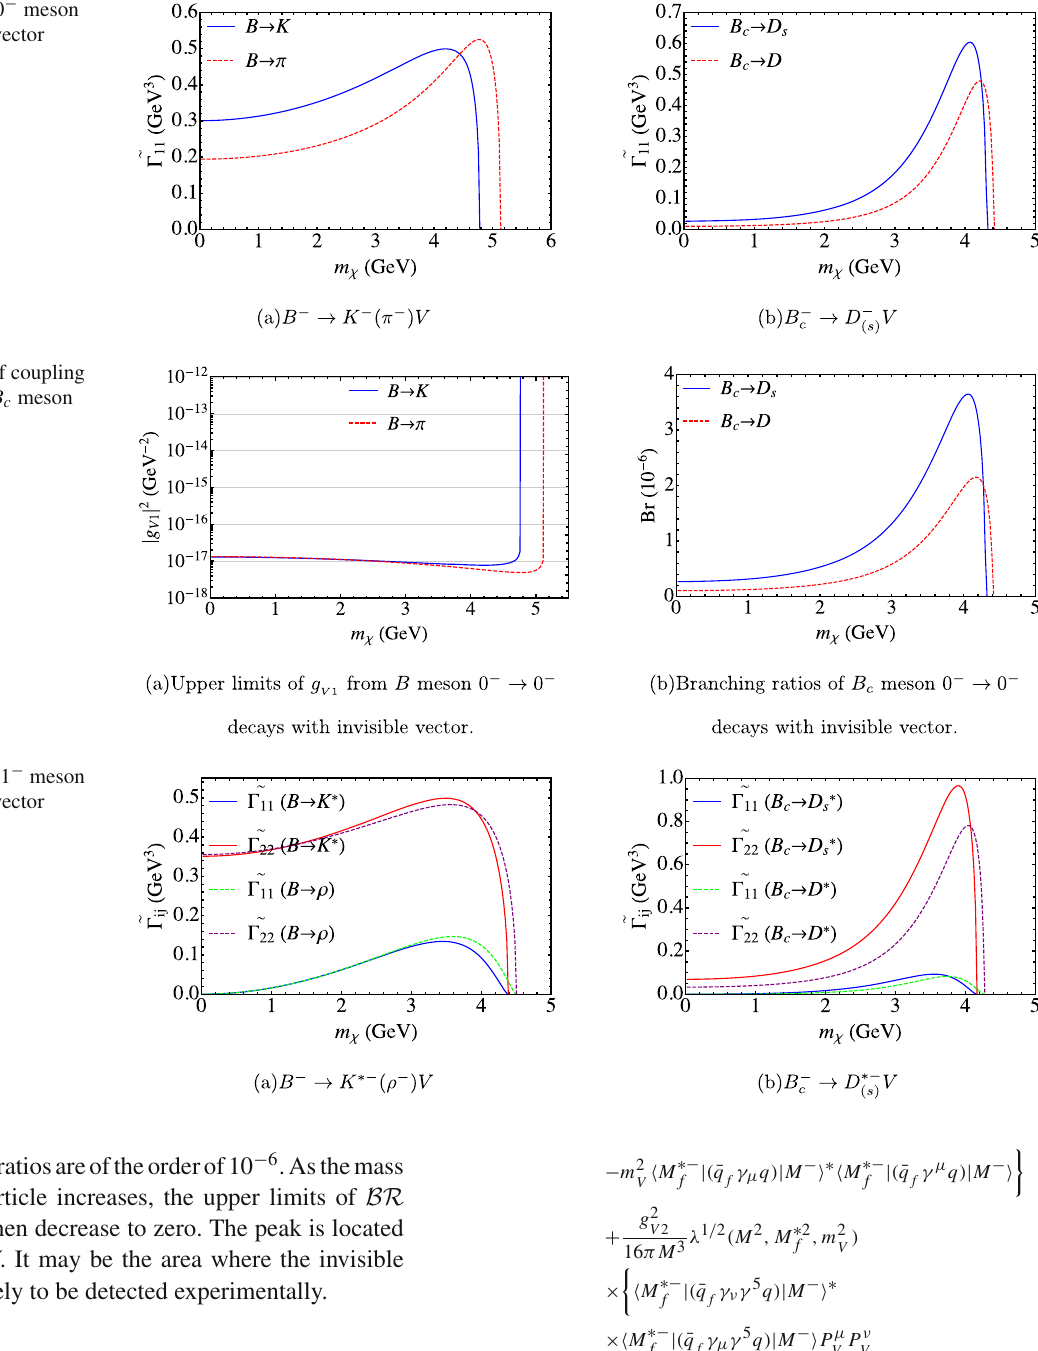
Fig. 9 Upper limits of coupling constants and BR of B c meson with invisible vector